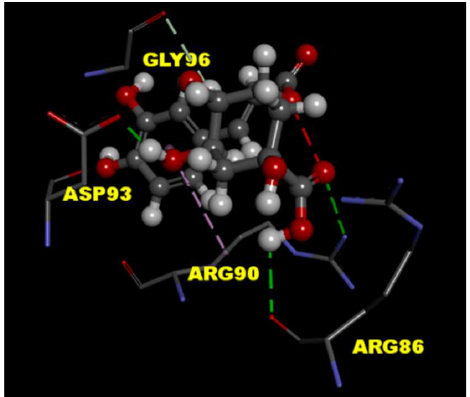
Figure 4. Molecular docking of CGA to P/Q-type Ca 2+ channel protein. The interaction between CGA with the binding site of molecular structure of P/Q-type Ca 2+ channel protein (PDB ID 3BXK) was predicted by the Discovery Studio 4.1 software. Hydrogen-bonding interactions (green lines) of protein–ligand as shown.